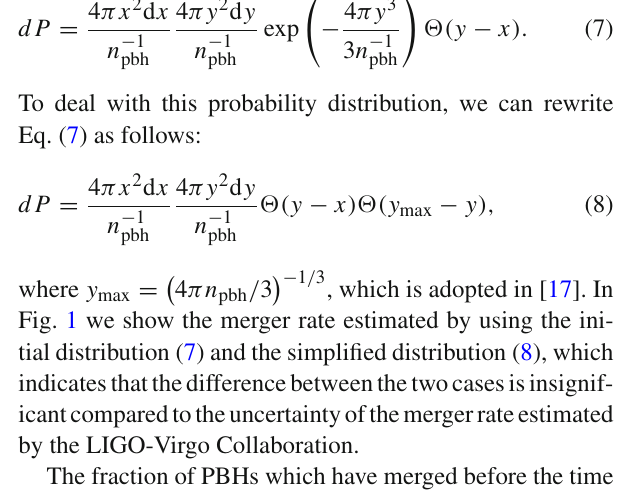
In Fig. 2 is a schematic illustration on calculating G ( t )